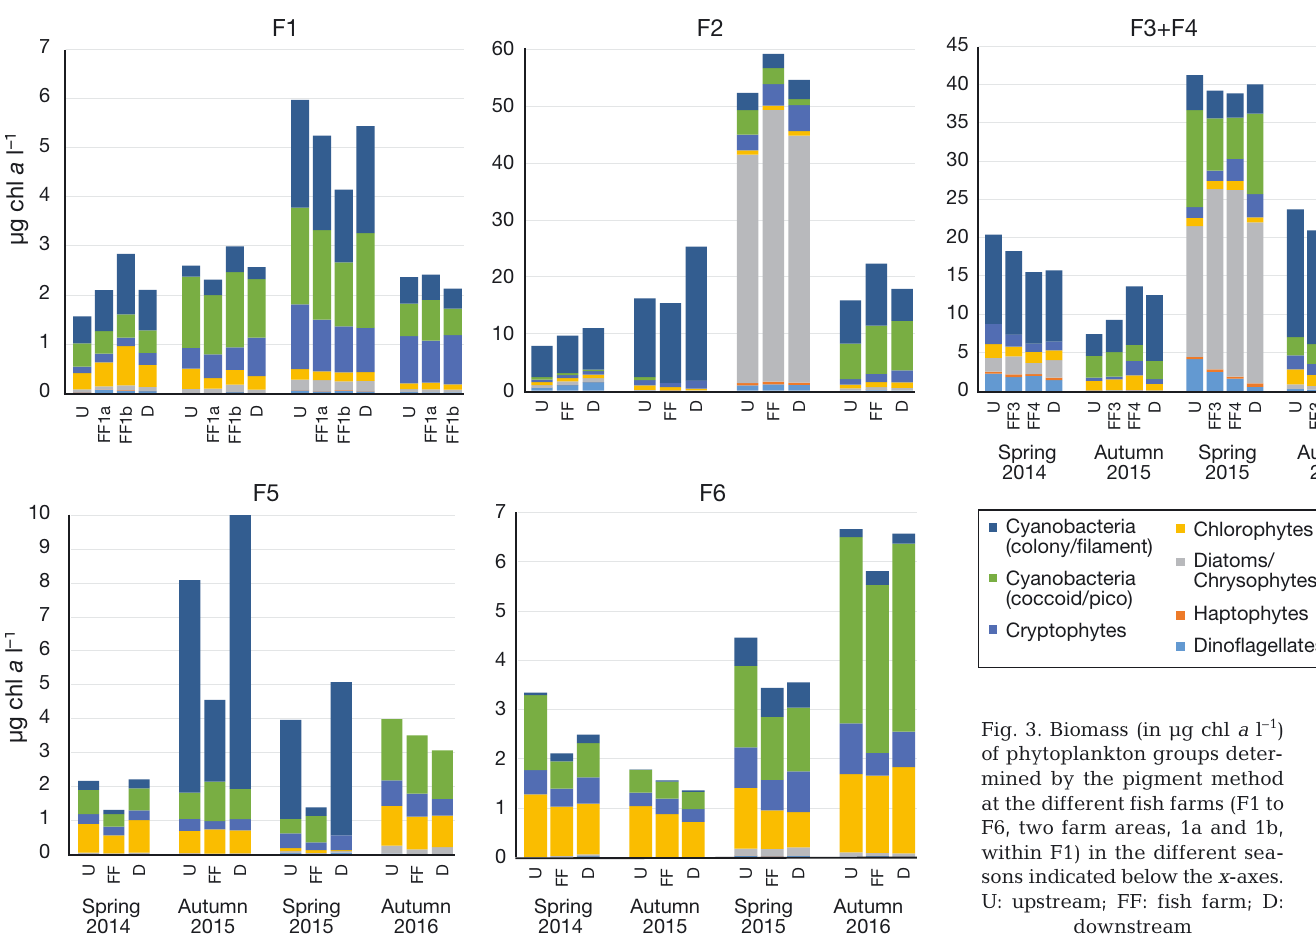
Fig. 3. Biomass (in µg chl a l –1 ) of phytoplankton groups deter- mined by the pigment method at the different fish farms (F1 to F6, two farm areas, 1a and 1b, within F1) in the different sea- sons indicated below the x